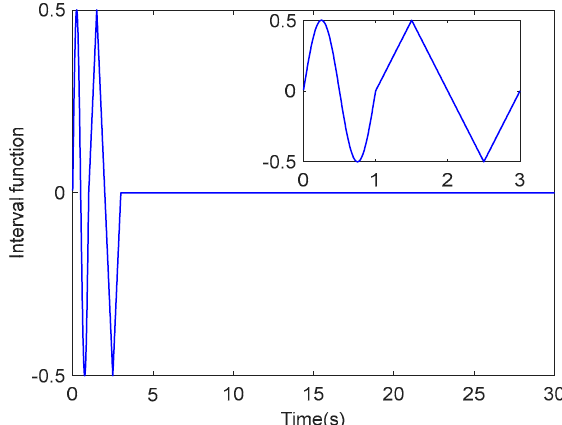
Figure 19. Curve of the constructed function with strong dynamic nonlinearity.